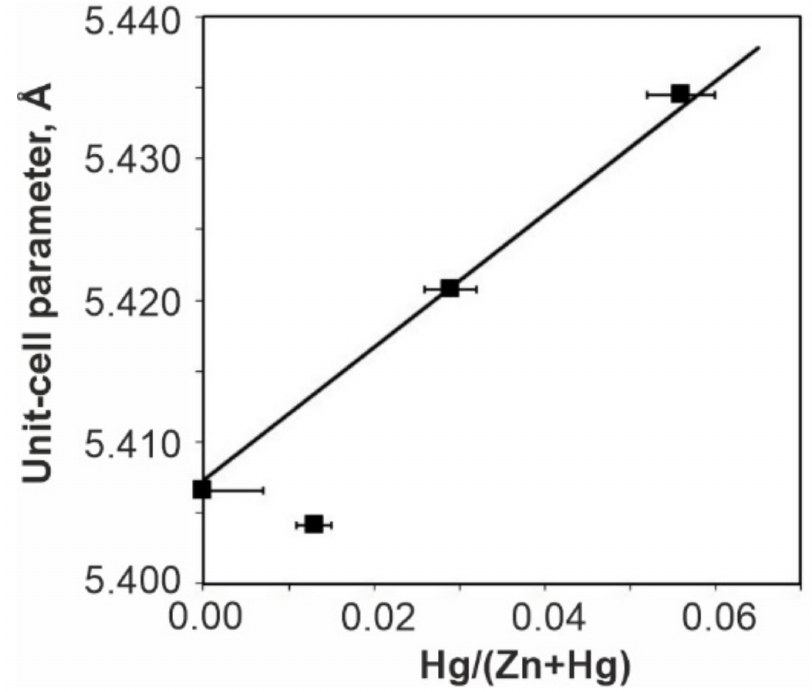
Figure 18. Unit-cell a-parameter of (Zn,Hg)S vs. Hg/(Zn + Hg)